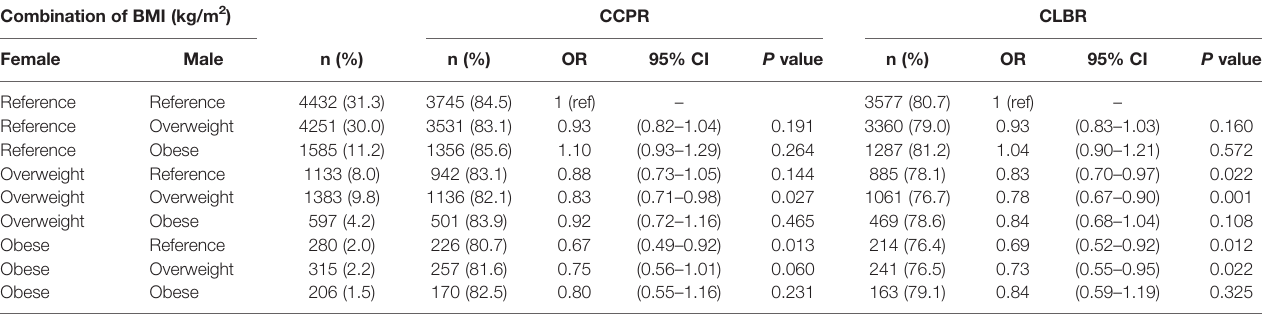
TABLE 4 | Results from logistic regression analysis of joint couple BMI on pregnancy outcomes in IVF/ICSI cycles. Combination of BMI (kg/m 2